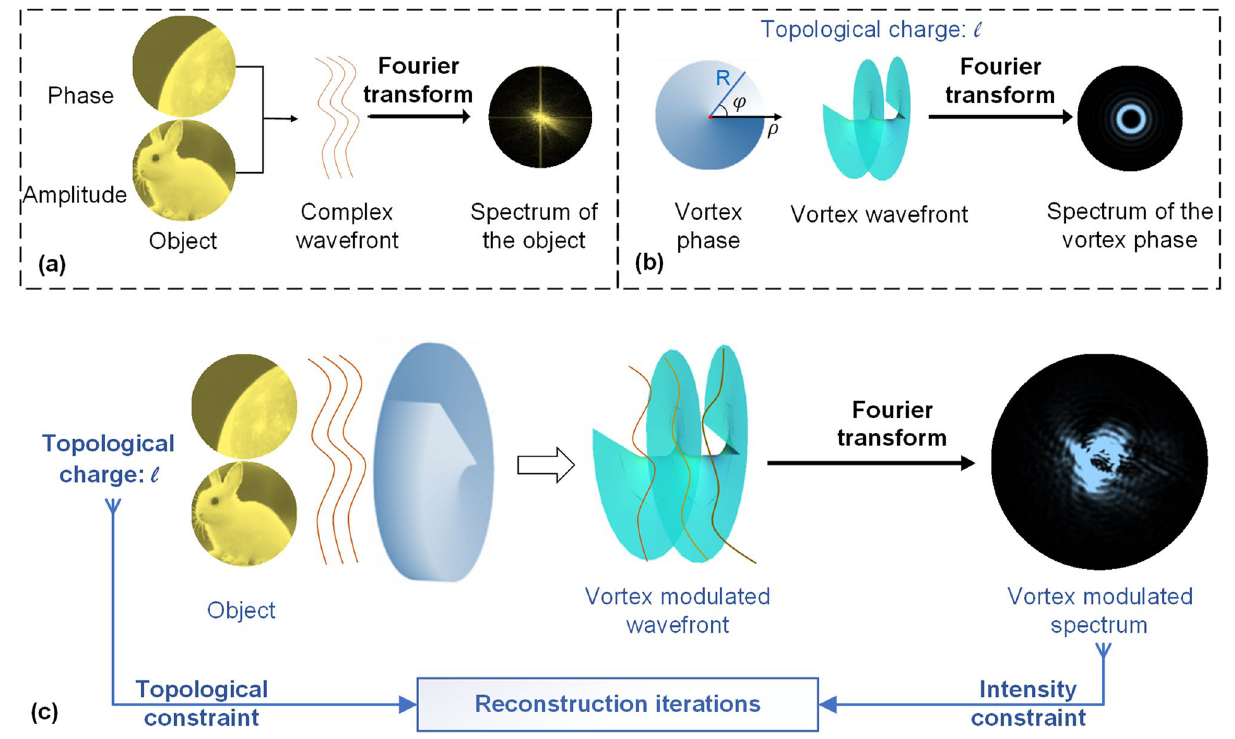
Figure 1. Schematic of the vortex modulation method. (a) Phase and amplitude of the complex-amplitude object and its Fourier spectrum, which are shown in grayscale images with yellow hue; (b) vortex phase with topological charge l ; (c) the complex-amplitude object modulated with the vortex phase and its Fourier spectrum with topological